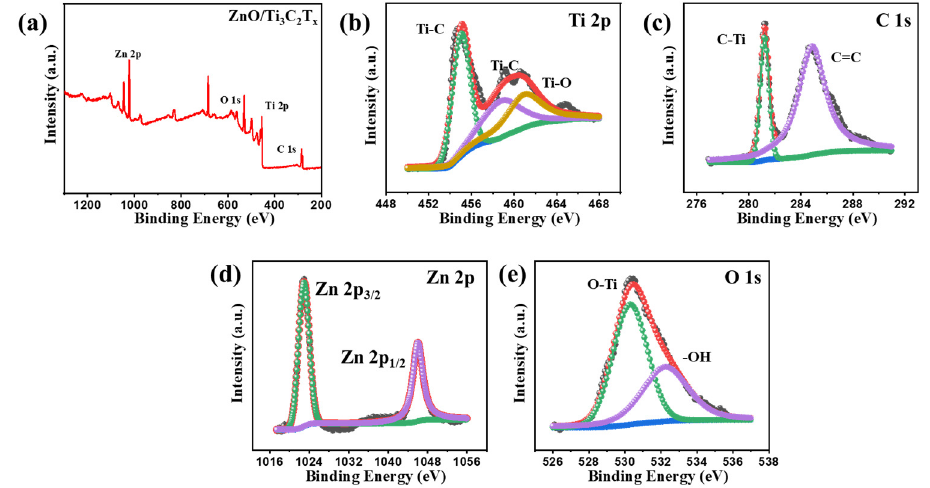
Figure 5. ( a ) Overall XPS spectrum of ZnO/Ti 3 C 2 T x nanocomposite (ZT2). Focused XPS spectra of ( b ) Ti 2p, ( c ) C 1s, ( d ) Zn 2p, and ( e ) O 1s, respectively.